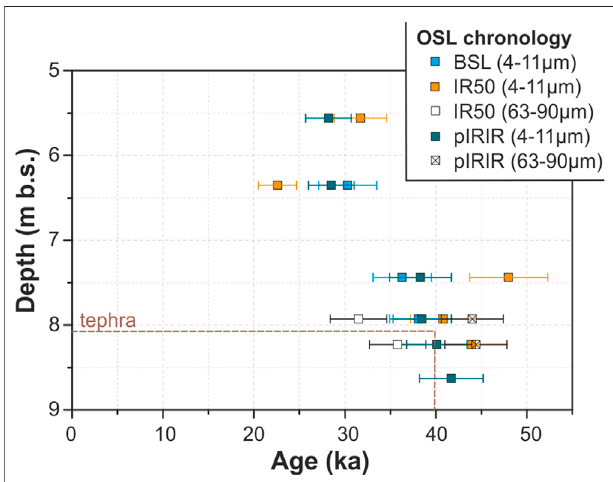
FIGURE 4 | Luminescence ages depicted in an age-depth plot. The locationofthetephra layerisshownwithadashed line.OSLagesaregivenas average and error bars show standard error (1 σ